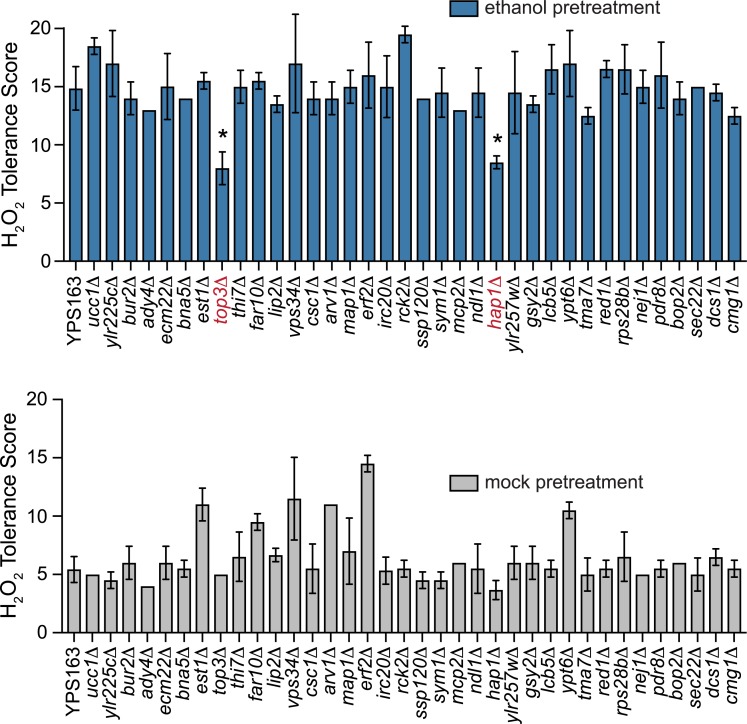
Ethanol-induced cross protection against H2O2 in YPS163 requires HAP1 and TOP3.Deletions of all non-essential genes within the 1.5-LOD support interval of the chromosome XII QTL peak were constructed in JL111 (YPS163 MATa haploid) background and tested for defects in acquired H2O2 resistance. Each plot shows the mean and standard deviation of 2 independent biological replicates, with the exception of the JL111 control (35 replicates). The replicates for several strains all had the same tolerance score and thus zero standard deviation (see S1 Table for raw numerical data). Asterisks represent acquired H2O2 resistance that was significantly lower than wild-type YPS163 (* P < 0.001, one-way ANOVA).